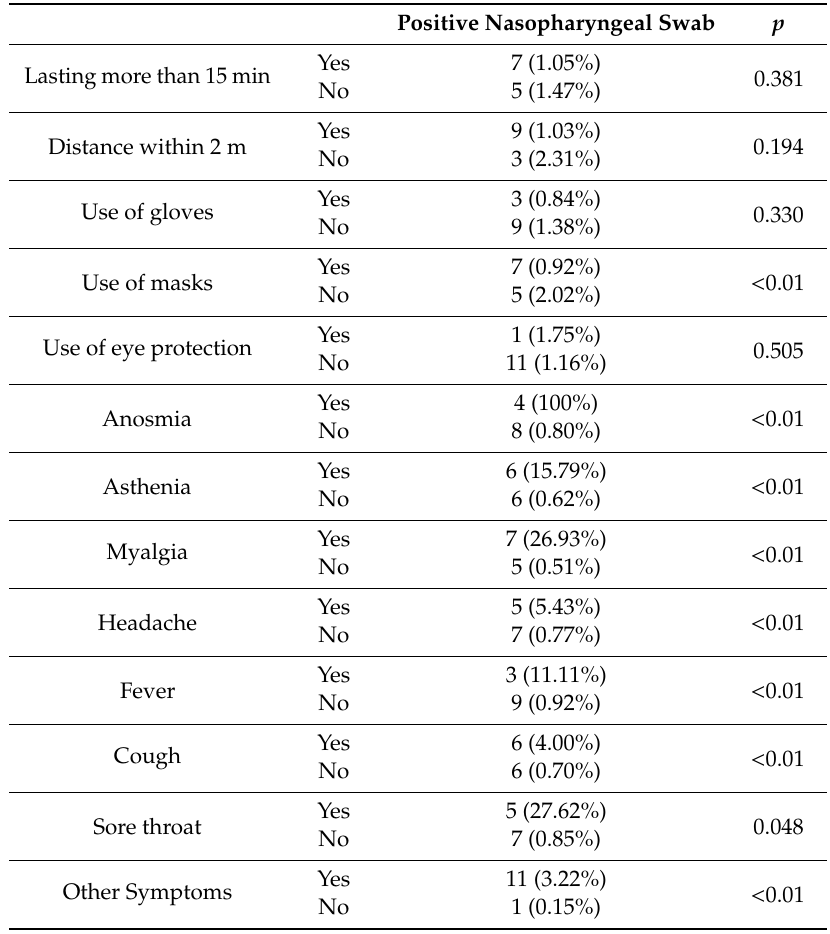
Table 1. Correlation between case investigation characteristics and results of the nasopharyngeal